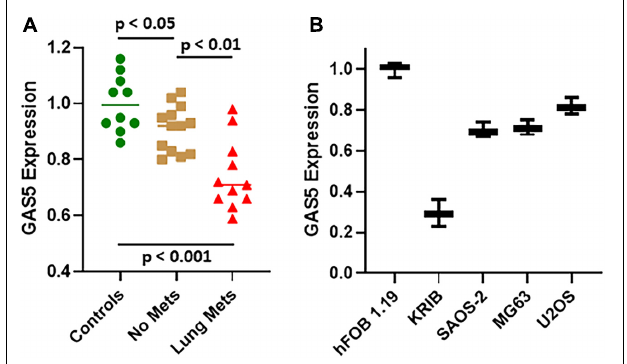
FIGURE 1 | Growth arrest specific 5 (GAS5) expression in osteosarcoma patients and cell lines. Expression of GAS5 was analyzed in panel (A) patient samples and (B) cell lines, using quantitative real-time PCR (qRT-PCR). Individual p values are mentioned for the direct comparisons of individual patient